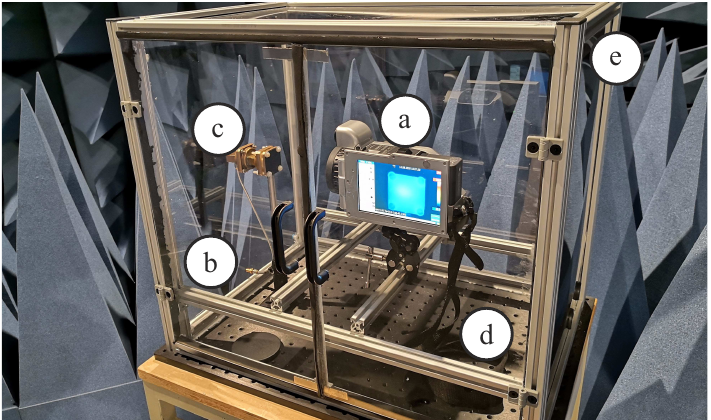
Figure 8. Photography of the realized setup containing: ( a ) Thermal camera, ( b ) through-hole microwave connection, ( c ) microwave device under test, ( d ) universal mechanical mounting board, ( e ) rear absorber